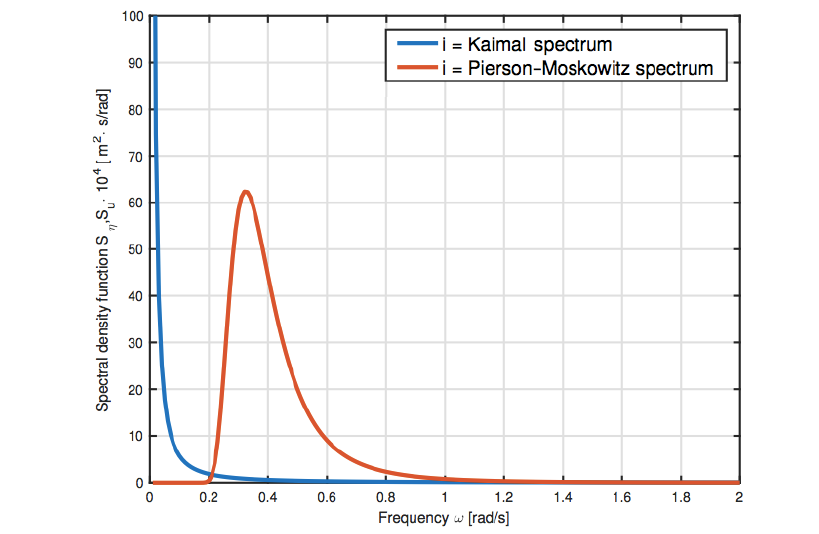
Figure 11. Wave and wind spectral density function.